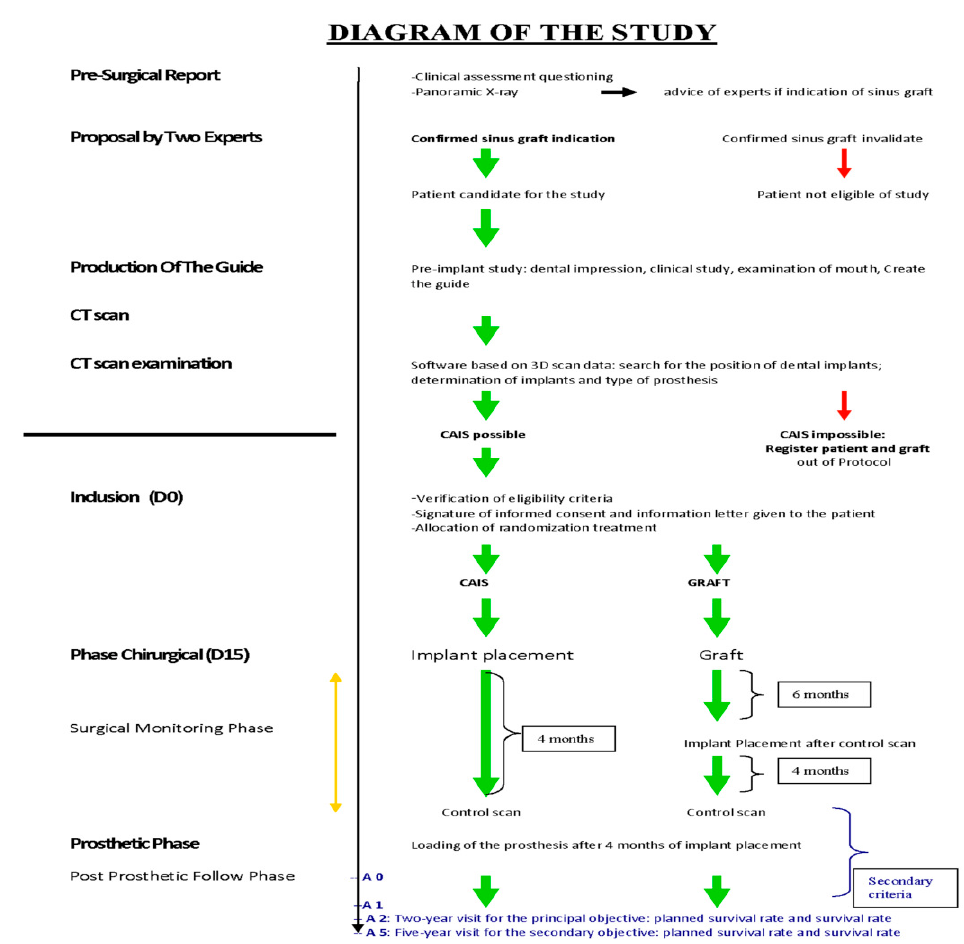
Figure 1. Diagram of the study. CAIS: computer-aided implant surgery. CT: computed tomography; A: year; D: day.